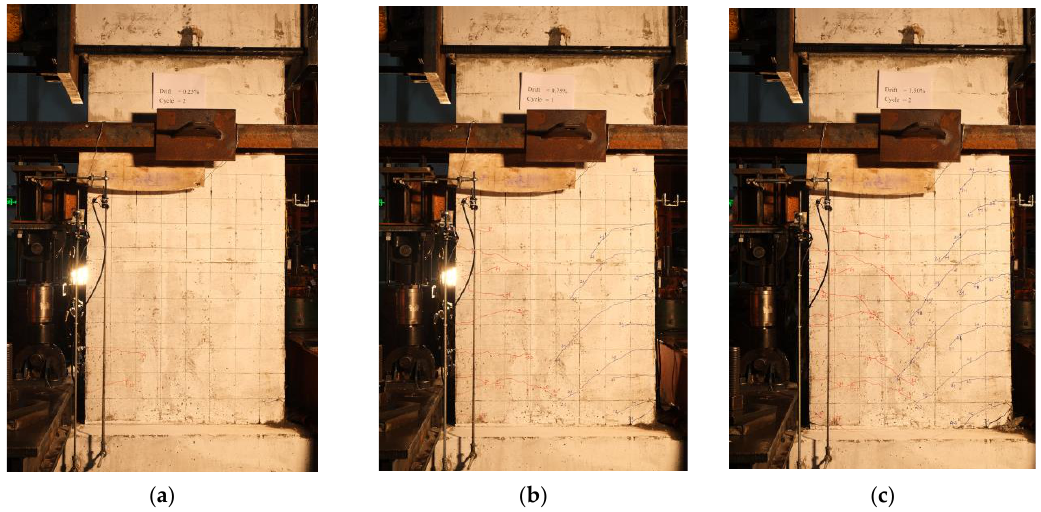
Figure 12. Cracking development of wall piers. ( a ) θ = 0.25%; ( b ) θ = 0.75%; ( c ) θ = 1.5%. The initiation of concrete crushing was observed at the bottom of the wall boundaries, corresponding to θ of 2.0%. Along with the further increase of θ , the concrete crushing became more severe and started to spall off. When θ arrived at 4.0%, the ultimate conditions were reached (Figures 13 and 14). The longitudinal rebars at the bottom of the wall boundaries yielded in all three subassemblies. Considerable shear rotation of the SCB was fully developed with no fracture in CS-2, while the web and flange of the SCBs fractured in the CS-1 and CS-3 subassemblies.